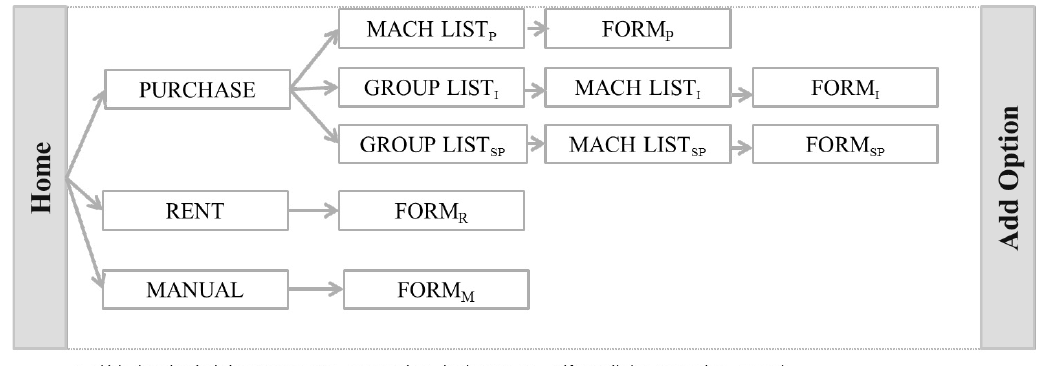
Figure 2: Flowchart of MACHoice’s use, the user must select one of 3 options: Purchase , Rent and Manual . This selection triggers the display of different forms and selected